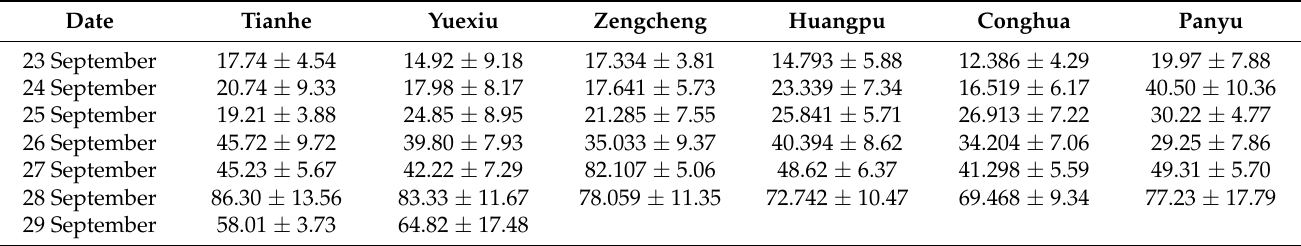
Table 1. Summary statistics for the mobile monitoring sampling